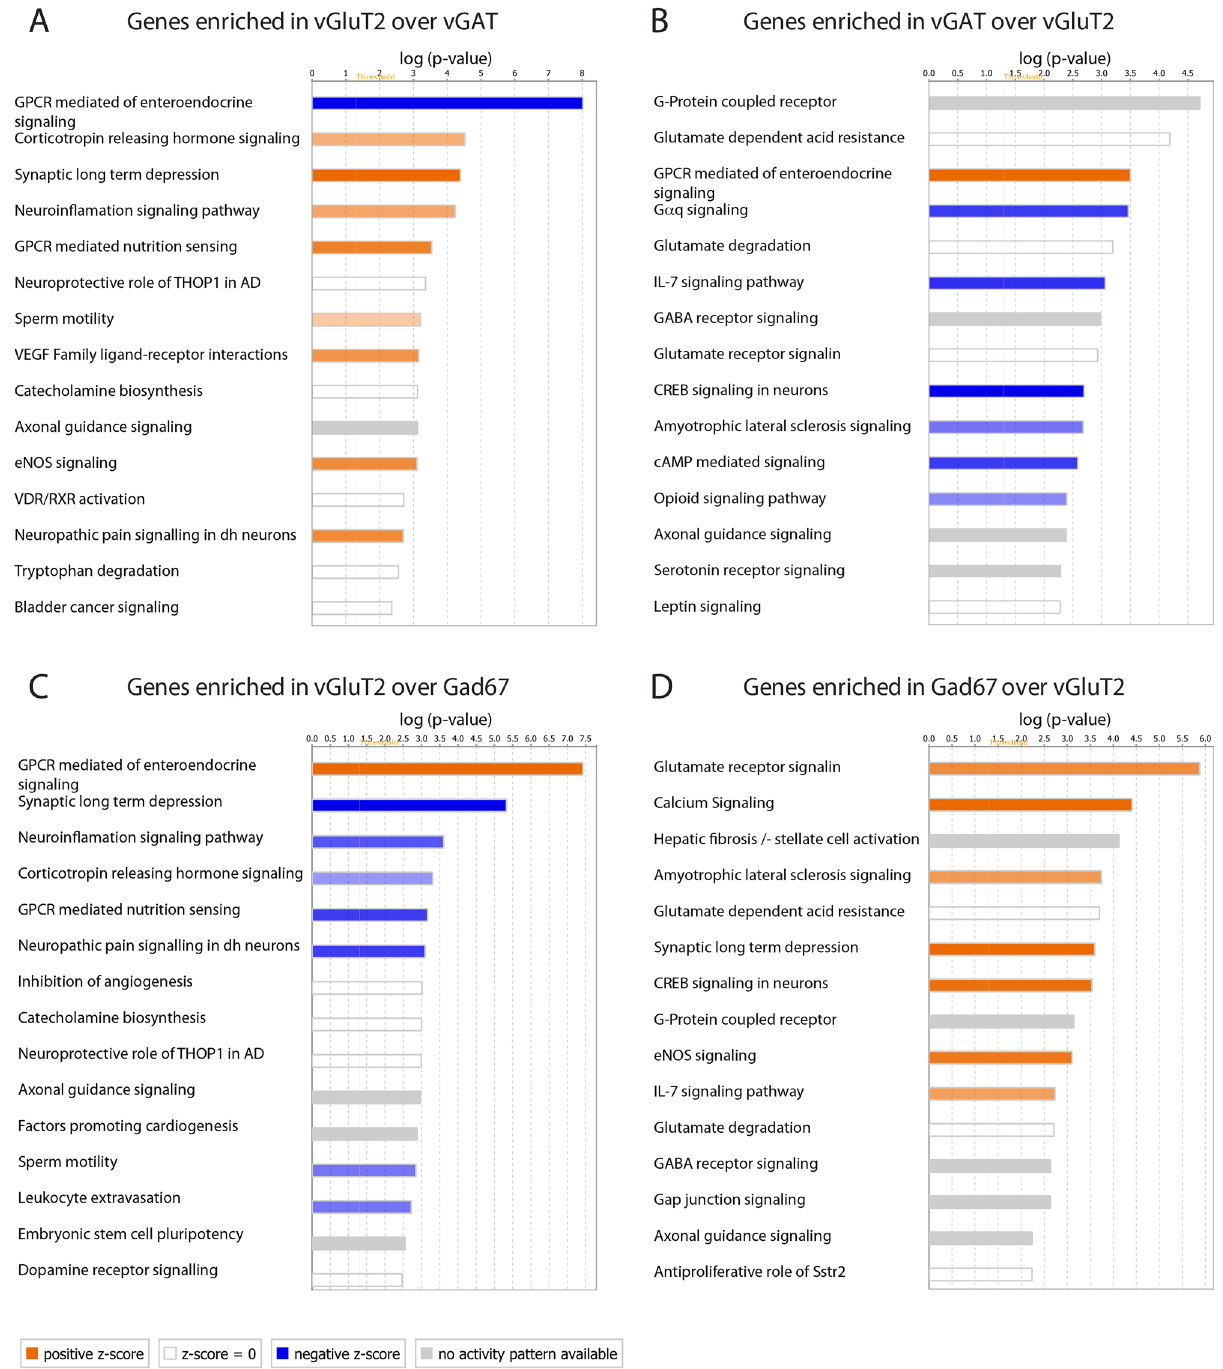
Figure 4. Pathway analyses with the enriched genes in the comparison of vGluT2::bacTRAP to vGAT::bacTRAP and Gad67::bacTRAP. 15 most significantly enriched pathways within the genes enriched in the comparison of ( A ) vGluT2 vs. vGAT, ( B ) vGAT vs. vGluT2, ( C ) vGluT2 vs. Gad67 and ( D ) Gad67 vs. vGluT2. ( A – D ) Bar length indicates significance, color key indicates activation z-score. Orange: increased activity of the pathway predicted. Blue: decreased activity of the pathway predicted. White: z-score = zero or very close to zero (overall pathway activity is neither increased nor decreased). Gray: no prediction on pathway activity